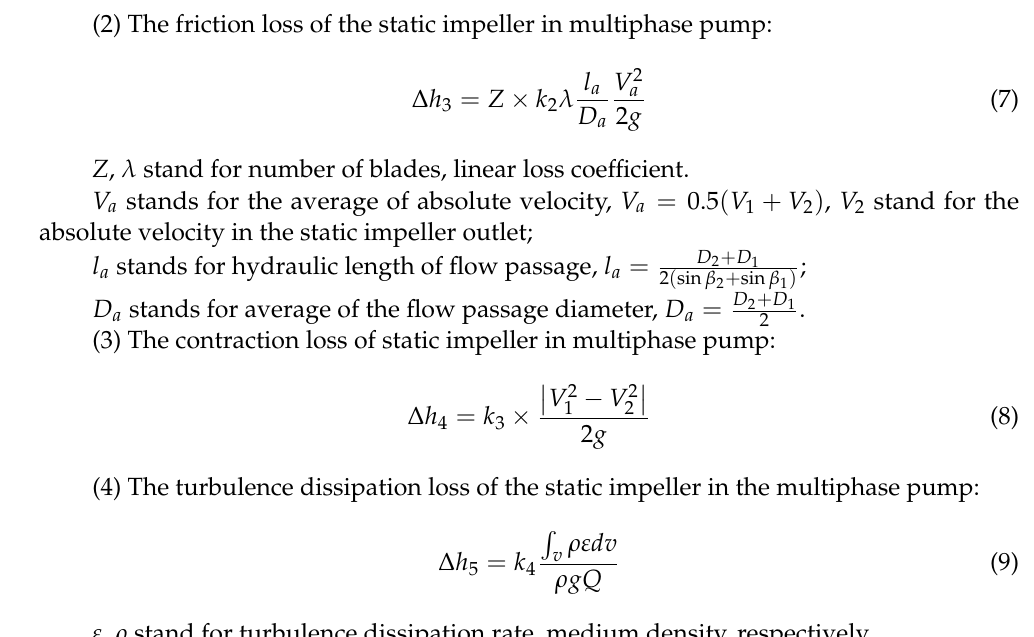
Table 1. The performance geometric parameters of the multiphase pump.